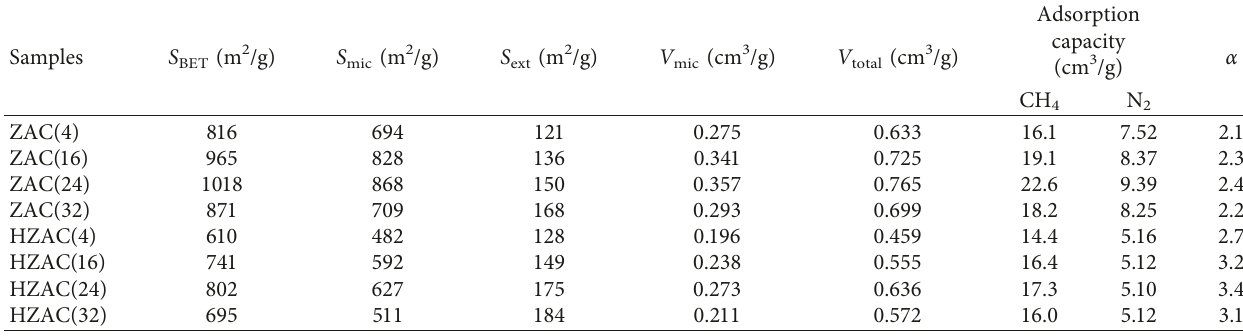
Table 1: Pore structure properties and CH 4 /N 2 adsorptive separation performance of samples.